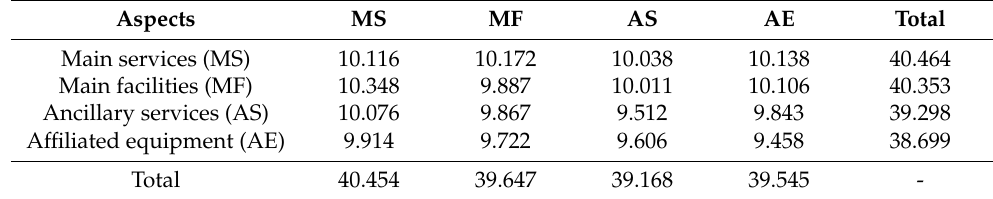
Table 6. The full influence matrix ( T